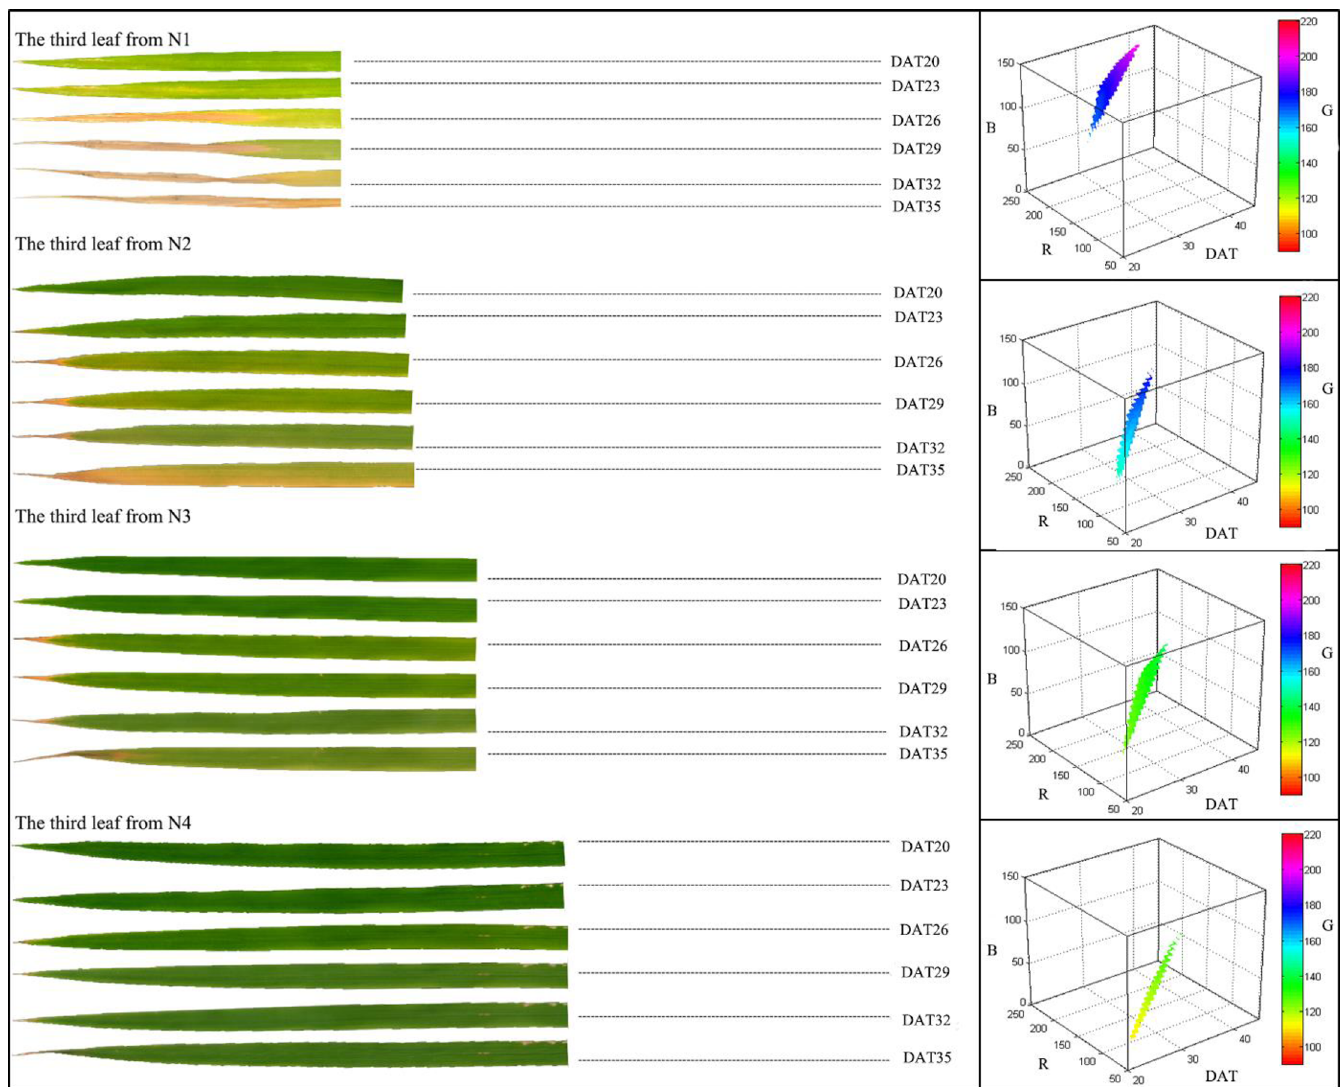
Fig 4. Leaf etiolation process under different N treatments. “X axis” represents time (DAT: day after transplanting), “Y axis” represents red (R), the “Z axis” represents blue (B) and the color bar represents green (G).